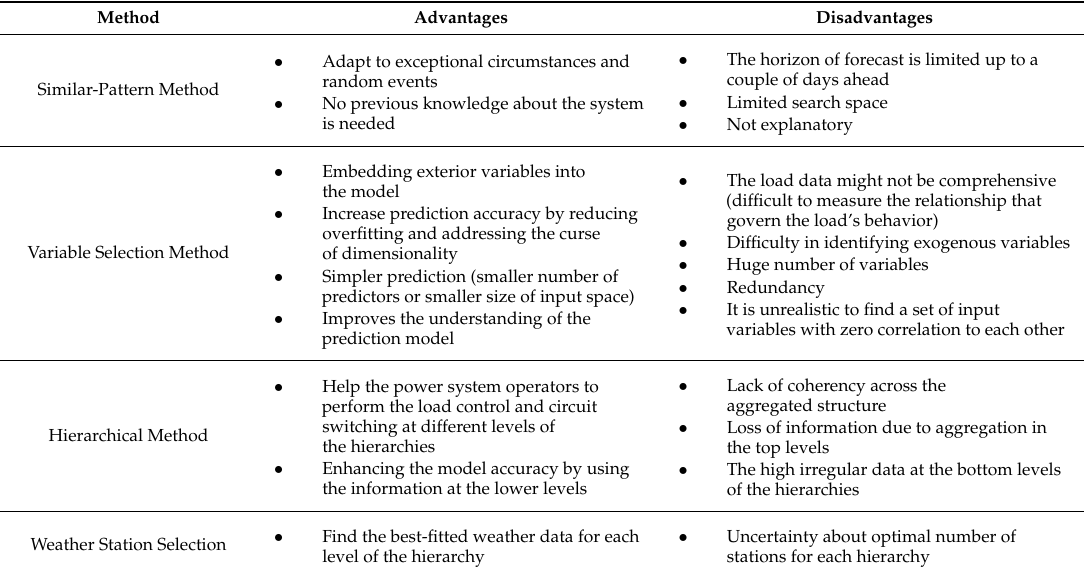
Table 5. Advantages and disadvantages of STLF